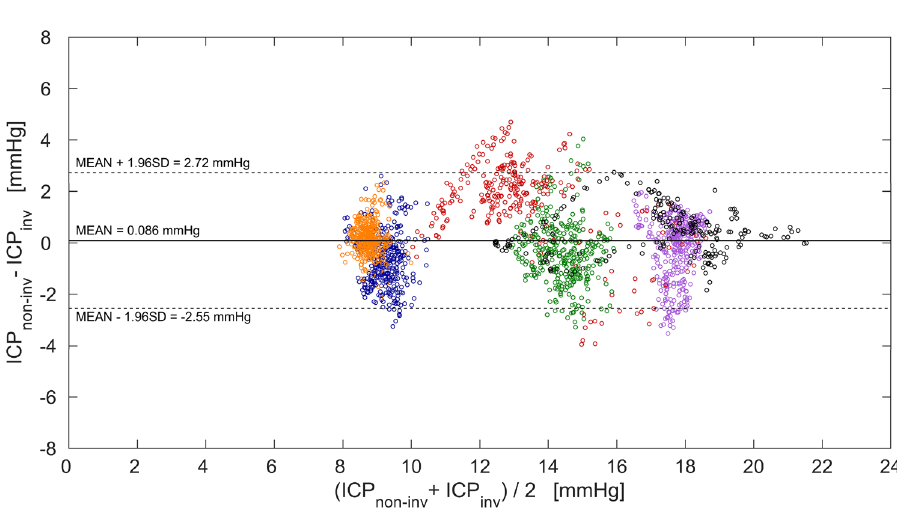
Figure 5. Bland–Altman plot showing the distribution of the measured differences between intracranial pressure monitored directly using invasive Codman ICP monitor (ICP inv ) and indirectly using two-depth transcranial Doppler (ICP non-inv ) in the entire pressure range obtained in all six patients. Paired data points collected from each of the six patients are separated by colors: first patient—black, second patient—violet, third patient—blue, fourth patient—red, fifth patient—orange, sixth patient—green. The thick horizontal line indicates the total mean of the measured differences, while the two dashed horizontal lines indicate the standard deviation (SD) of ± 1.96 of the measured